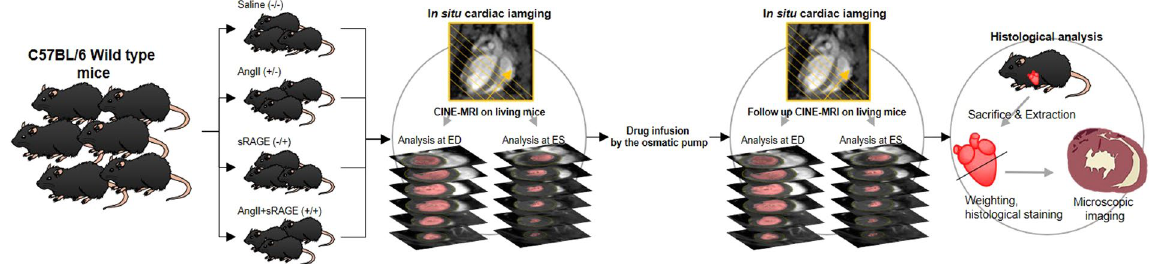
Figure 1. Schematics demonstrate the experimental process for the cardiac function tracking of angiotensin II- induced LVH models using in situ and 9.4T